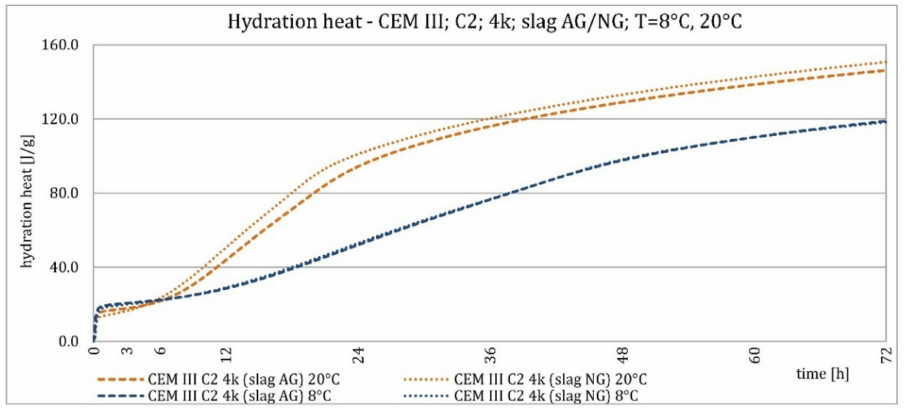
Figure 15. Hydration heat of C2 clinker based non-modified cement CEM III/A, containing slags differing in fineness at 8 ◦ C and 20 ◦